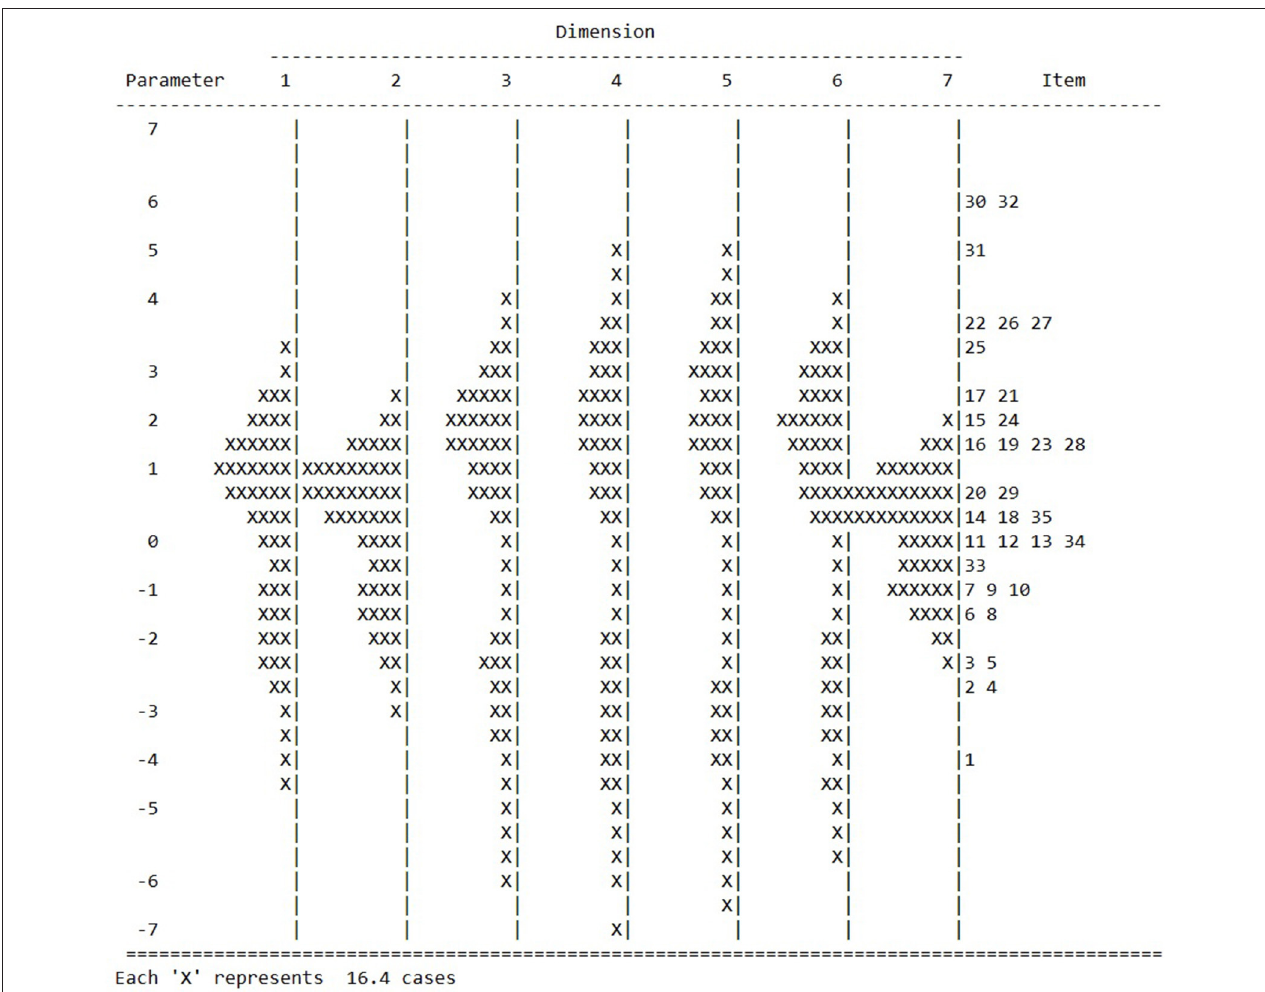
FIGURE 1 | Item- and person parameters of the ATEM 3–6